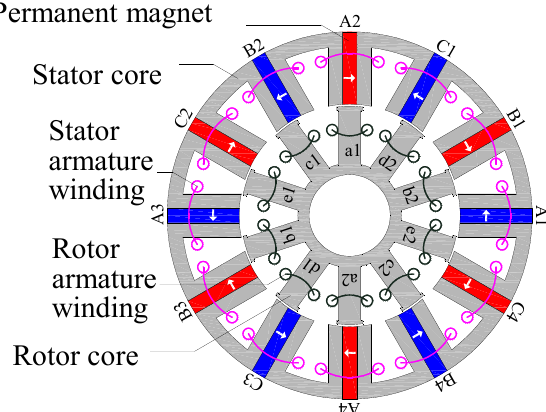
Figure 1. Topology of the DA-FSPM.